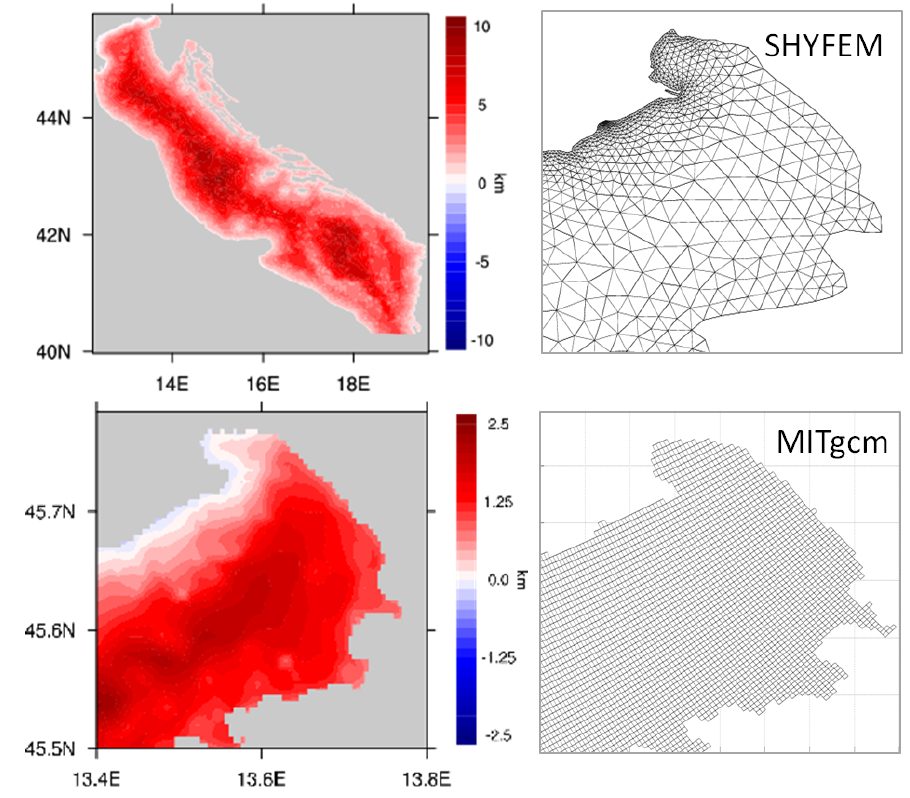
Figure 1. Maps of the difference in grid resolution (in km) between MITgcm and SHYFEM (SHY minus MIT) in the entire Adriatic (top left), and a close up of the north-eastern coastal area, the Gulf of Trieste (bottom left). Red indicates where MITgcm is higher resolved than SHYFEM while blue indicates the reverse. The two grids, SHYFEM (top right) and MITgcm (bottom right) are shown for the area of the Gulf of